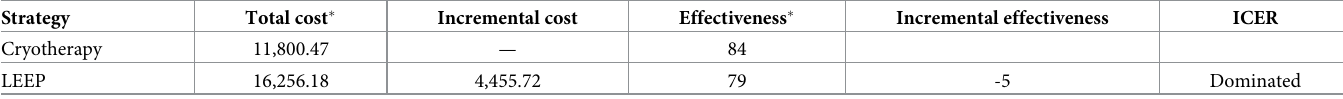
Table 6. Cost-effectiveness analysis comparing cryotherapy versus LEEP for treatment of CIN2+ among HIV-positive women (US$ 2015), intention-to-treat analysis.